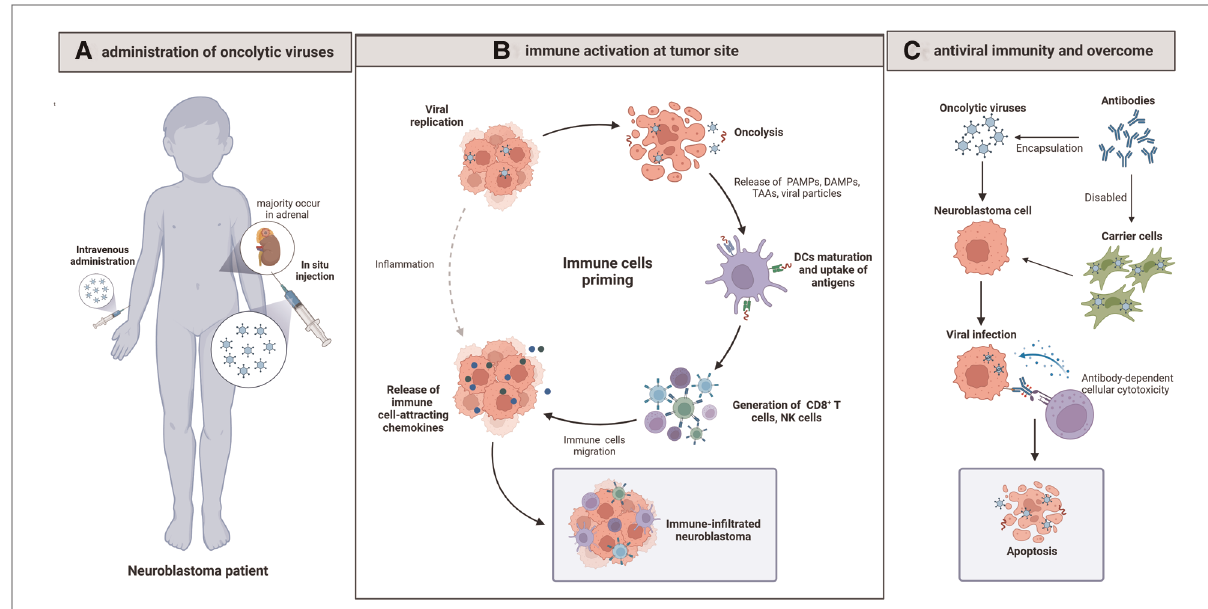
FIGURE 1 Oncolytic virotherapy for neuroblastoma. ( A ) The in situ injected or intravenously administrated OVs reach the NB site and cause oncolysis by cytopathic effect, causing cell lysis, cell apoptosis and necrosis. ( B ) The released PAMPs, DAMPs and TAAs activate CD8+T cells after presentation by dendritic cells, and the released immune cell-attracting chemokines recruit NK cells, CD8+cells and dendritic cells, changing the suppressive TME into an active one and contributing to the immune-in fi ltrated neuroblastoma. ( C ) Delivering OVs with carrier cells can overcome antiviral immunity effectively and improve the ef fi cacy of